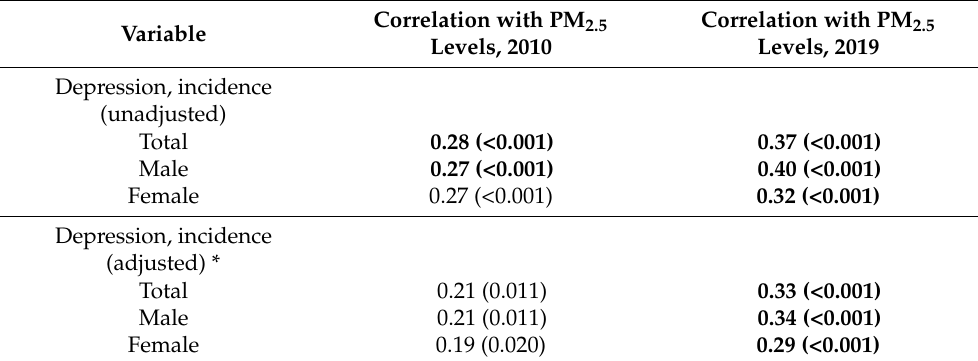
Table 2. Bivariate correlations between average annual PM 2.5 levels and the incidence of depression across countries. Correlation with PM 2.5 Variable